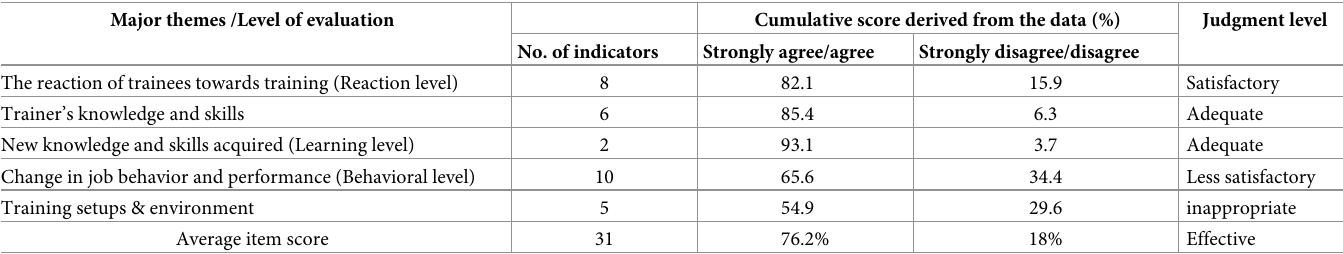
Table 8. A summary table of the effectiveness status of major evaluation themes in APHI_DB, northeast Ethiopia. Major themes /Level of